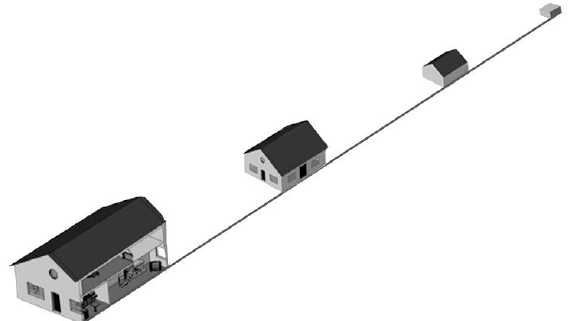
Figure 3. A conceptual representation of distance LOD : when the object is distant ―enough‖ from the viewer, we can use a very low LOD and this should be perceptually indistinguishable for the